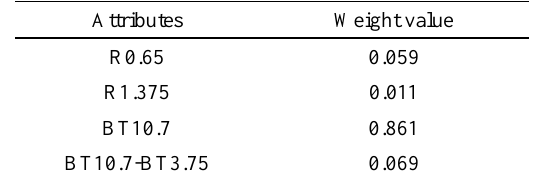
Figure 5. Flowchart of decision tree cloud detection algorithm In decision tree cloud detection algorithm proposed by us, the four cloud detection indicators selected in 1.1 are used as index as classification criteria.